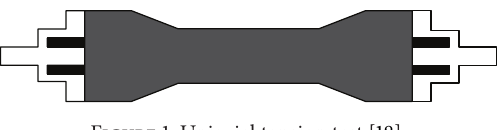
Figure 1: Uniaxial tension test